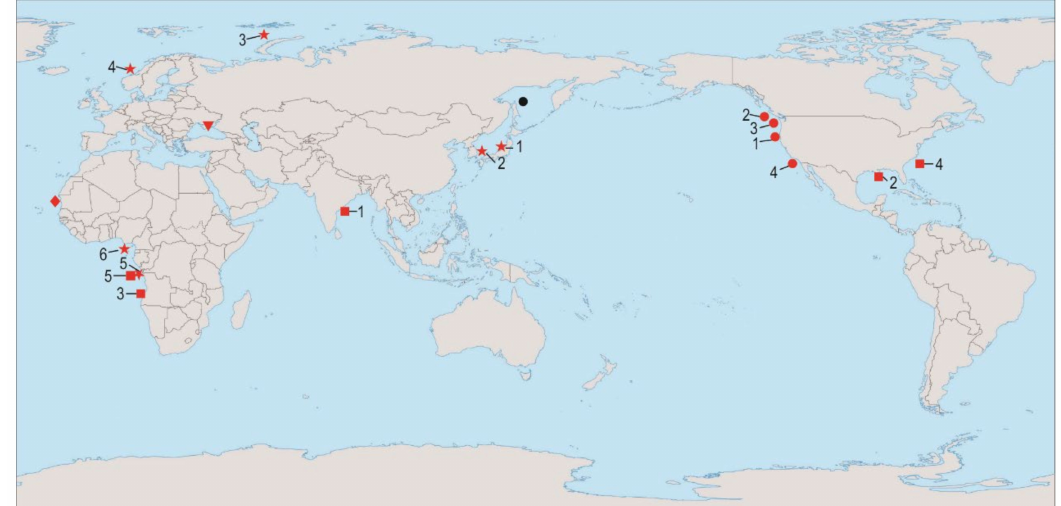
Figure 1. Distribution of the reported shallow subsurface and near-seafloor gas hydrate deposits at the global scale. Legends: Red stars represent fault-chimney-controlled deposits. 1—Joetsu Basin, Japan; 2—Ulleung Basin, Korea; 3—Barent Sea; 4—Mid-Norwegian margin; 5—the Lower Congo Basin; 6—Niger Delta Slope. Red squares represent the diapir-fault deposits. 1—Krishna–Godavari (KG) Offshore Basin, India; 2—Bush Hill, Northern Gulf of Mexico; 3—offshore Angola; 4—Blake Ridge Diapir; 5—the Lower Congo Basin. Red circles represent fault-controlled deposits. 1—Southern Hydrate Ridge; 2—the Bullseye cold vent; 3—Barkley Canyon; 4—Santa Monica Basin, offshore California. Black circle: Okhotsk Sea (a complex area may involve all deposit types above). Other cases: Red triangle: The Kerch seep area, Black Sea. Red diamond: The Mauritania